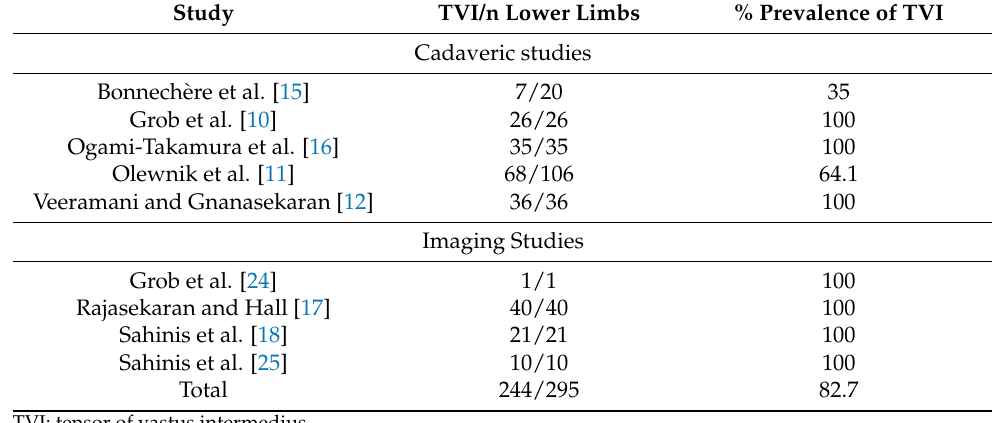
Table 2. Prevalence of tensor of the vastus intermedius between the studies.